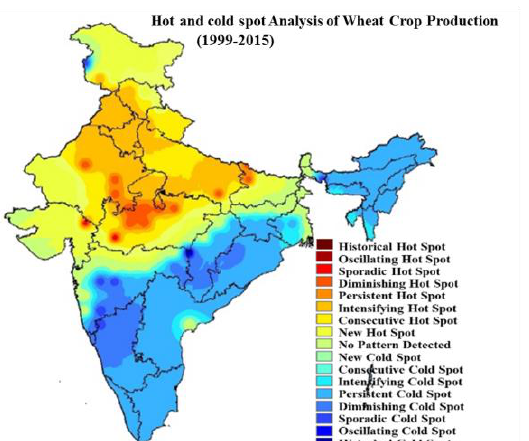
Figure 11 Emerging hot and cold spot analysis of wheat crop production